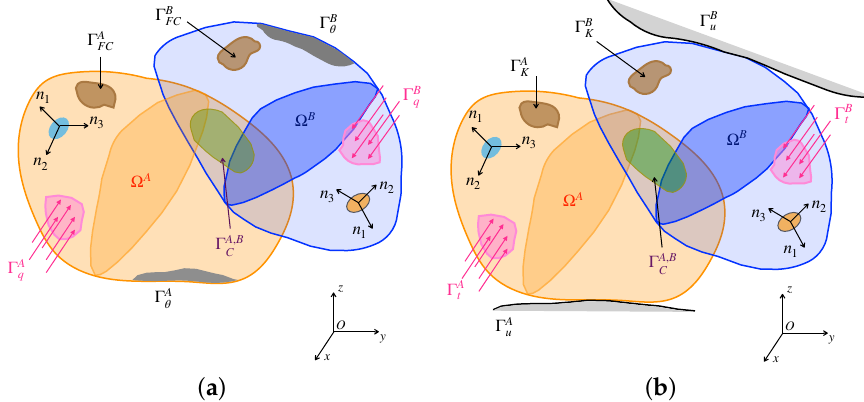
Figure 2. ( a ) Schema of the thermal problem. ( b ) Schema of the elastic